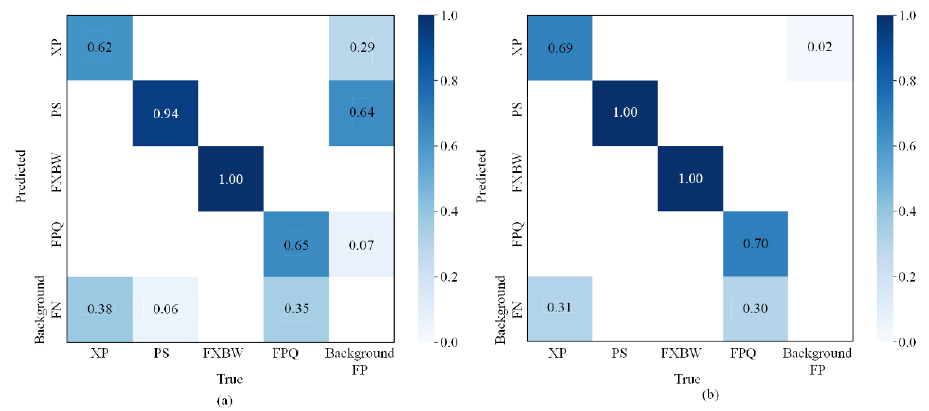
Figure 23. Confusion matrix. ( a ) YOLOv5; ( b ) depth-attention YOLOv5.